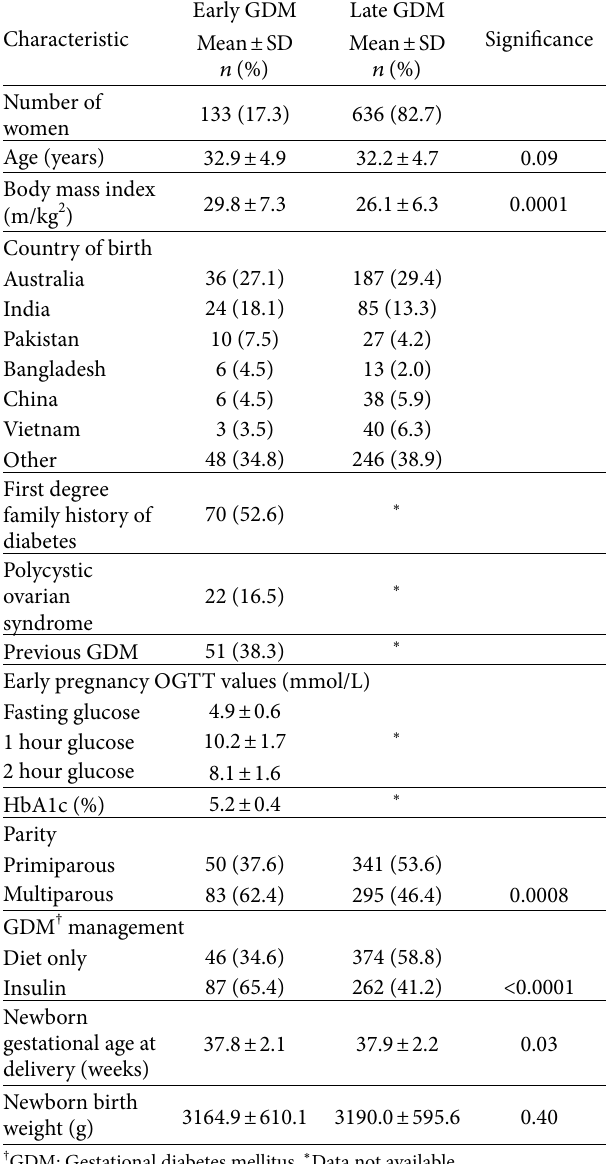
Table 1: Characteristics of the maternal and newborn study participants. Early GDM had a higher BMI, more multiparous pregnancies, higher use of insulin, and a lower gestational age.